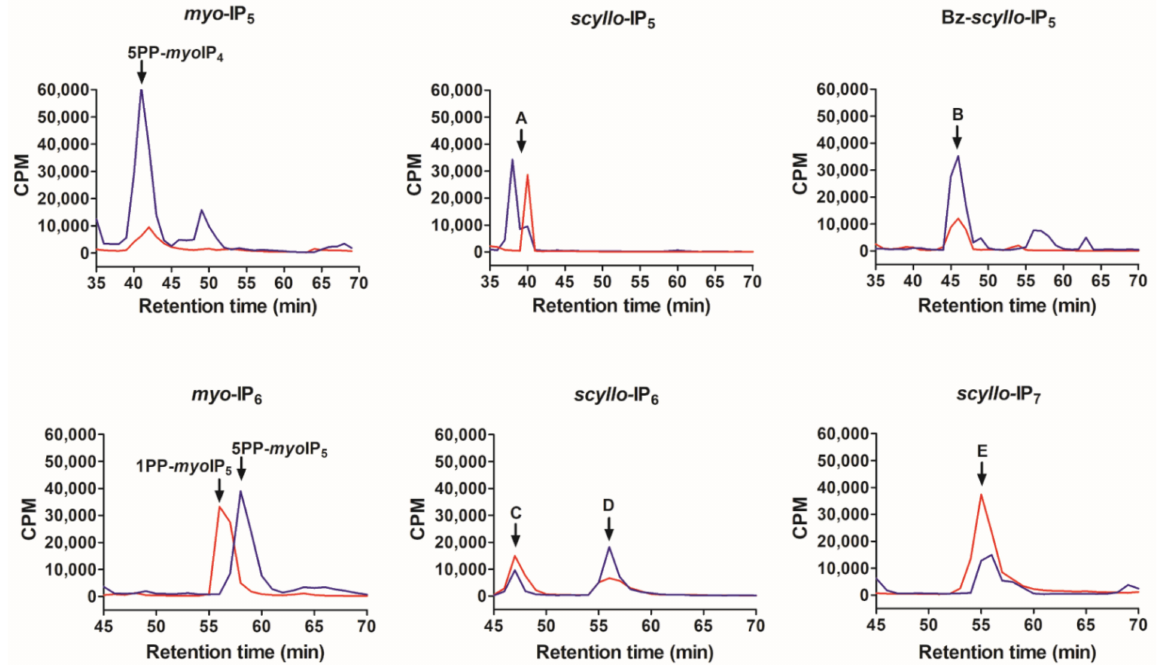
Figure 2. Chromatograms of the phosphorylated PPIPn products (indicated by arrows) formed by the catalysis of IP6K1 (blue) and VIP1-KD (red) on various IPn substrates. The IPn substrate used in each case is indicated above the chromatogram. The reaction products were resolved by strong anion exchange HPLC as described in Section 3.3. Retention times for standard myo -IPs were marked using radiolabeled inositol phosphates extracted from budding yeast (Section 3.3 and Supplementary Figure S2B). The traces represent one of four independent experiments. The well-characterized products of myo -IP 5 and myo -IP 6 are indicated. The PPIPn products of scyllo -IPs are likely to be as follows: A. PP- scyllo -IP 4 ; B. PP-Bz- scyllo -IP 4 ; C. PP- scyllo -IP 5 ; D. [PP] 2 - scyllo -IP 4 /PPP- scyllo -IP 5 ; E. [PP] 2 - scyllo -IP 4 /PPP- scyllo -IP 5 . The corresponding PPIPn products observed by PAGE analysis are similarly annotated in Figure S1. See Figure S2B,C for chromatograms of other myo -IPn and myo -PPIPn standards, and ATP, under the same